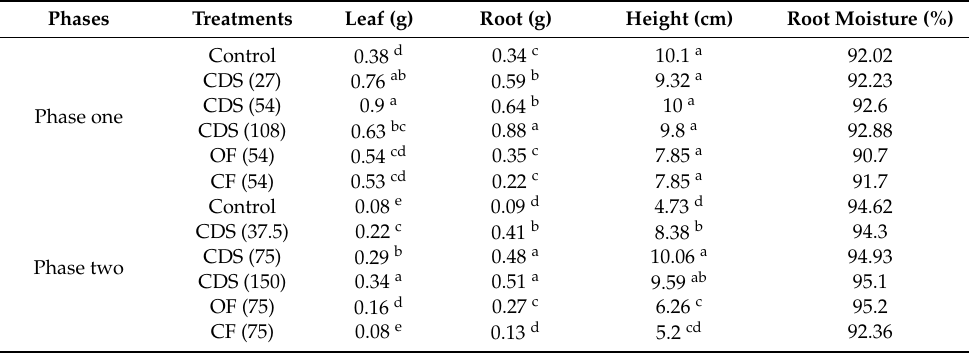
Table 10. Radish biomass, height and moisture of the treatments.